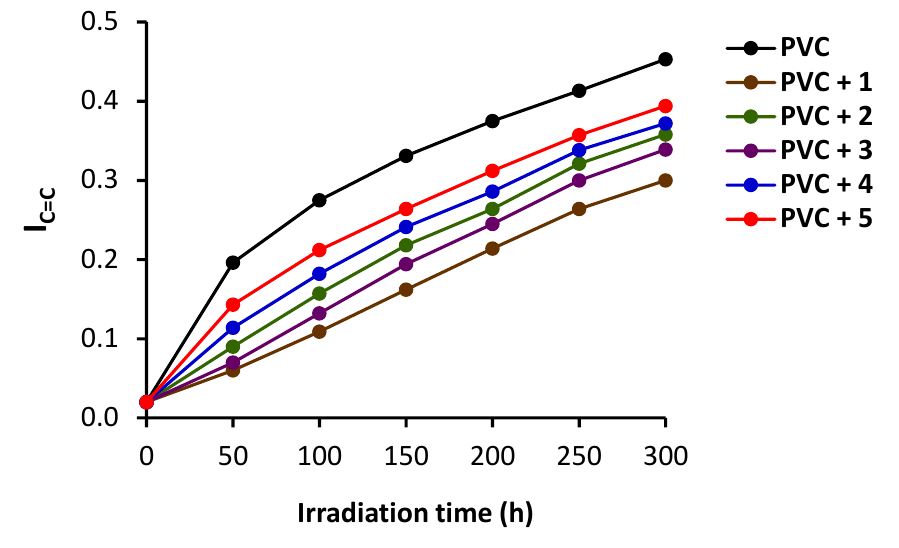
Figure 6. The I C=C of the irradiated PVC films.